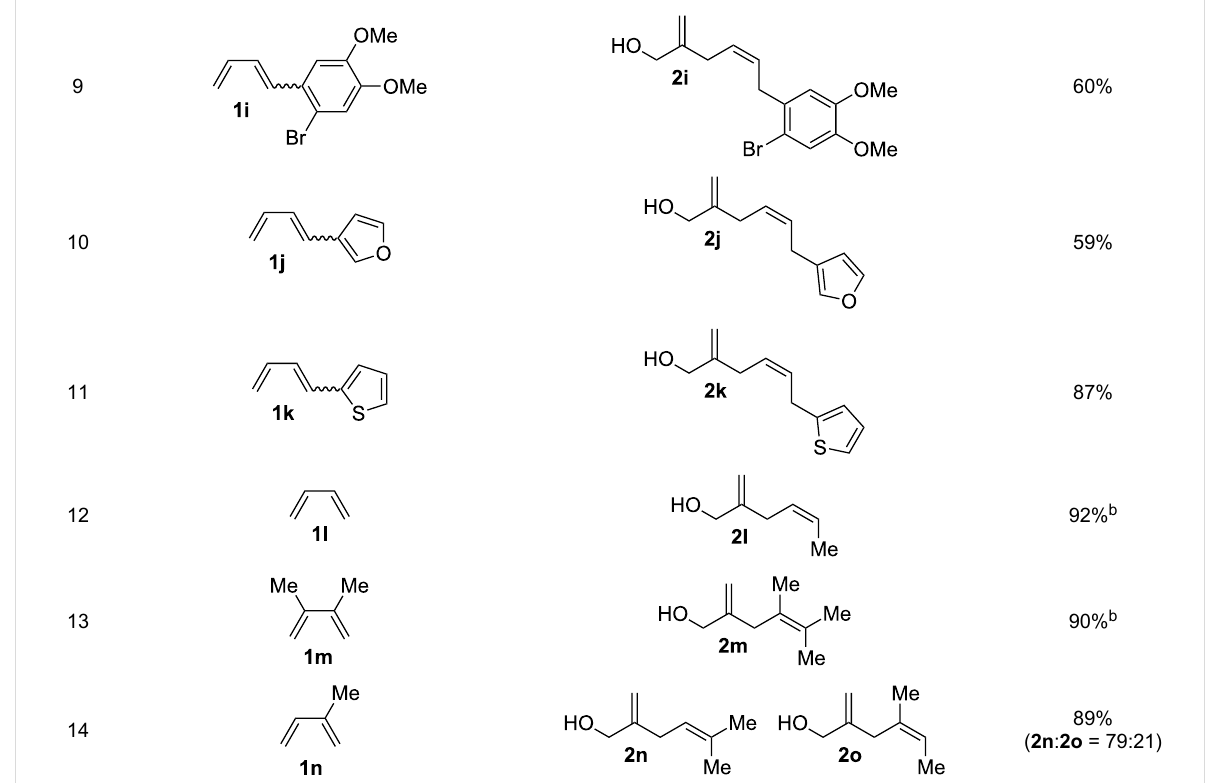
enide and tetraethylammonium bromide in CH 3 CN at room temperature in an undivided cell, using platinum foil electrodes (constant current 10 mA). In this investigation only diphenyl diselenide was used as selenium source. These reaction condi- tions led to the formation of products of type 3 as exclusive diastereomers (Scheme